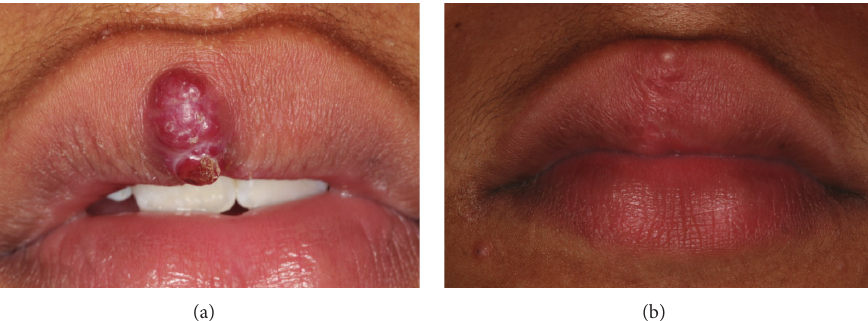
Figure 3: Clinical presentation of case 2. (a) Initial presentation revealed a firm asymptomatic nodule with reddish color, measuring approximately 1cm in diameter. (b) Presentation at 6-month